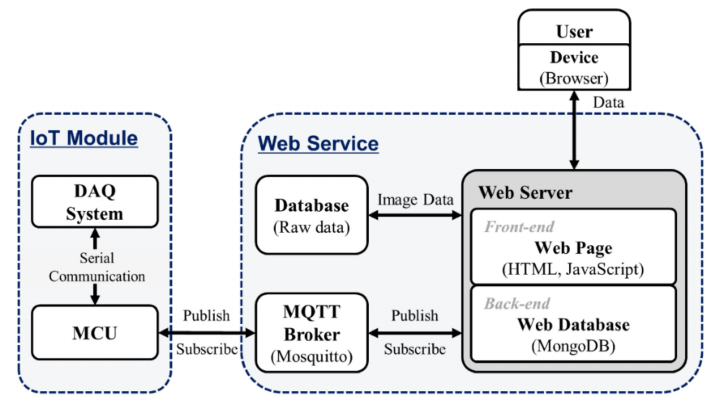
Figure 3. Software configuration of the IoT-TPLSM.